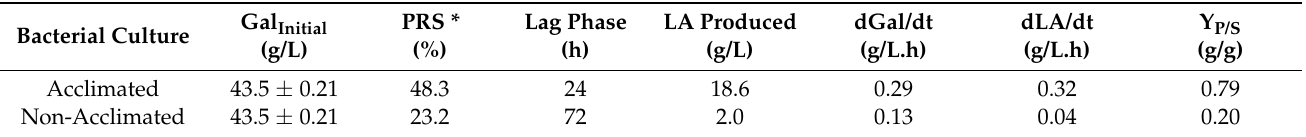
Table 5. Batch 72-h fermentation kinetics of lactic acid by acclimatized and non-acclimatized cultures of Lactobacillus pentosus , from detoxified Kappaphycus alvarezii hydrolysates in conical flask with 20 g/L CaCO 3 buffer, using a 1.2 g/L inoculum, at 37 ◦ C, and 150